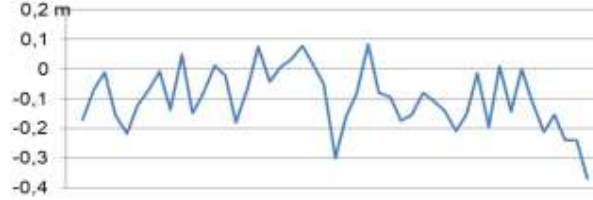
Figure 20. Systematic Z-discrepancies of Kompsat-3 DSM as function of Y after improvement with AW3D30